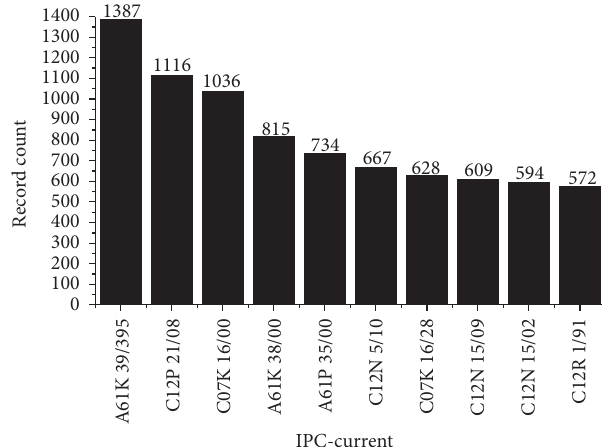
Figure 9: Current IPC codes used in the classification of the prospected